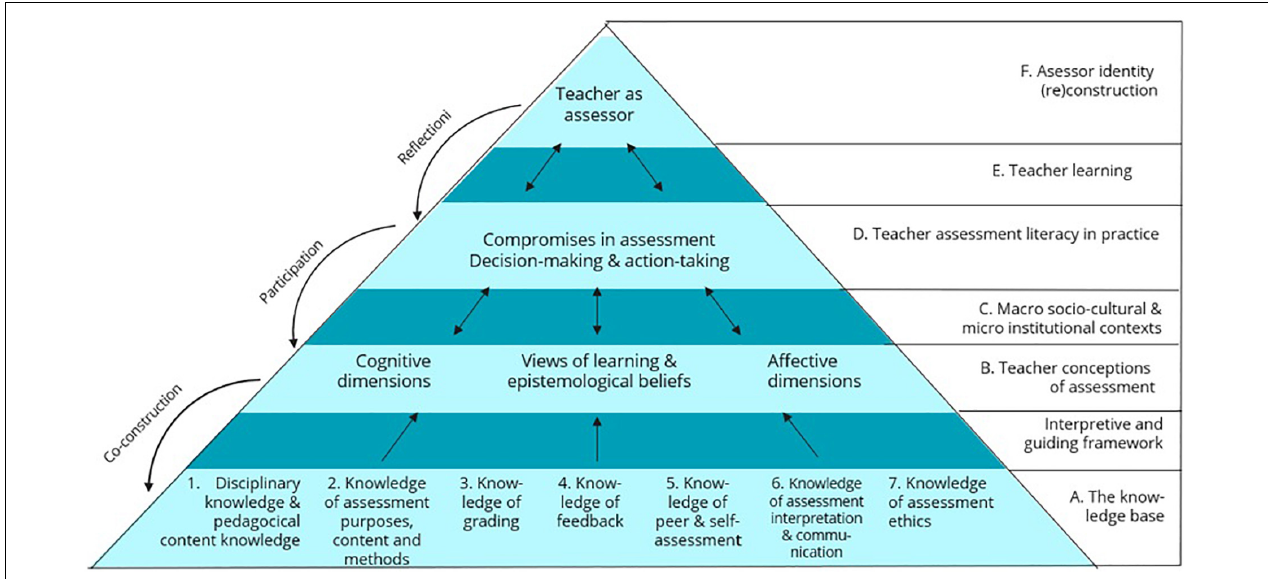
FIGURE 1 | A conceptual framework of teacher assessment literacy in practice (TALiP-model; Xu and Brown,